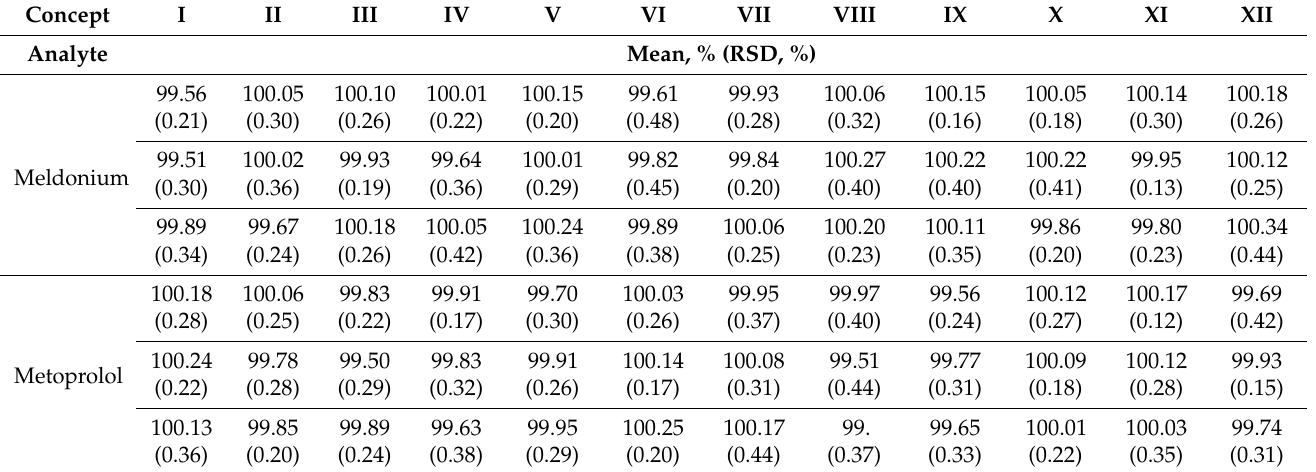
Table 3. Inter-day accuracy and precision